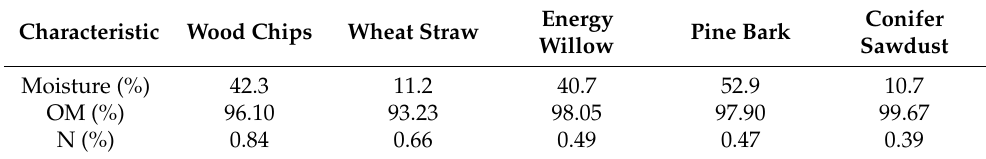
Table 2. Characteristics of lignocellulosic materials.